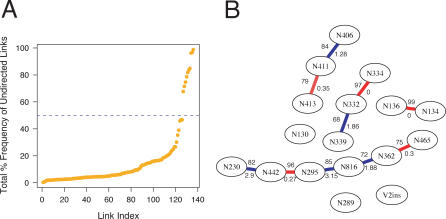
Consensus Bayesian Network of Highly Polymorphic PNGSs in the HIV-1 Envelope(A) Ordered distribution of frequencies that undirected links (i.e., arcs) occurred in replicate networks optimized on 100 random samples of 200 sequences from the alignment, expressed as a percentage (y-axis). A dotted line at 50% indicates an arbitrary cutoff, above which arcs were applied to assembling the consensus network.(B) Graph of consensus network. Each node (oval) represents the PNGS identified by its position in the HxB2 reference sequence, with one exception (V2ins) that represents an inserted PNGS downstream of the conserved N186. Arcs between nodes are labeled with percentage of occurrence above and odds-ratios below. An odds-ratio <1 (red) indicates mutual exclusion and >1 (blue) co-occurrence of PNGSs.